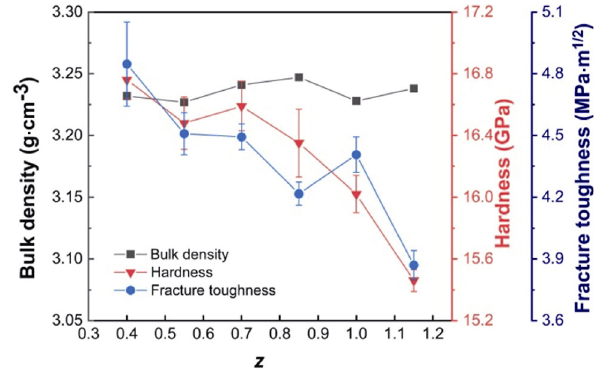
Fig. 6 Bulk density, hardness, and fracture toughness variations with z value.